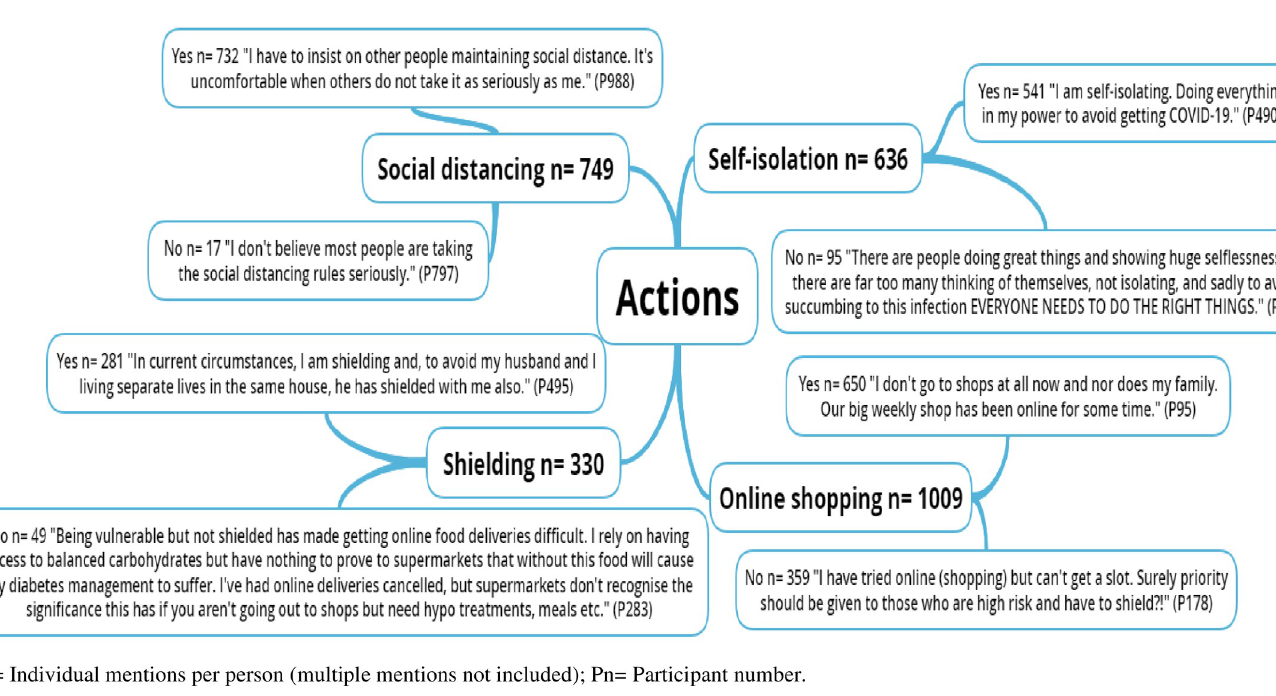
PLOS ONE | https://doi.org/10.1371/journal.pone.0259376 November11,